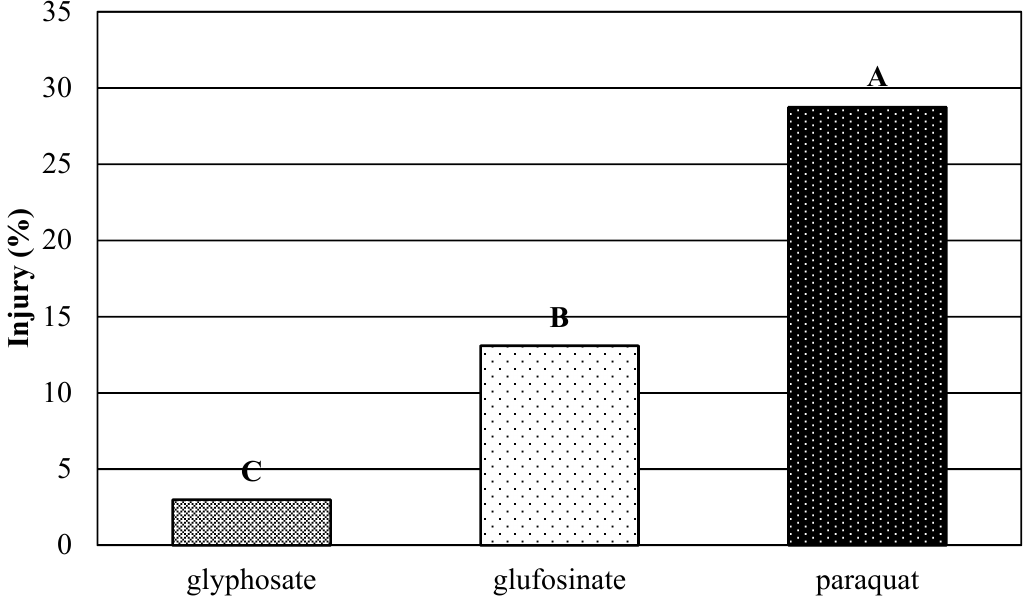
Figure 1. Grain sorghum injury from a simulated drift of glyphosate, glufosinate, and paraquat at 14 days after application (DAA) of herbicides in 2017. Data were averaged over application timings. Same letters on bars indicate no significant differences at p < 0.05, according to Fisher’s least significant difference test.